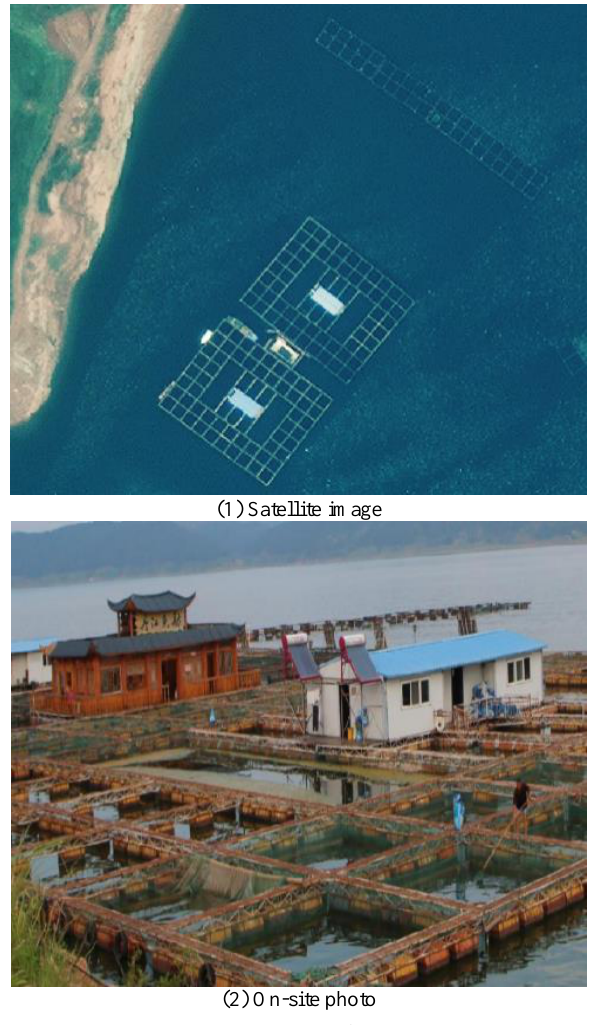
Figure 3. One type of net cages